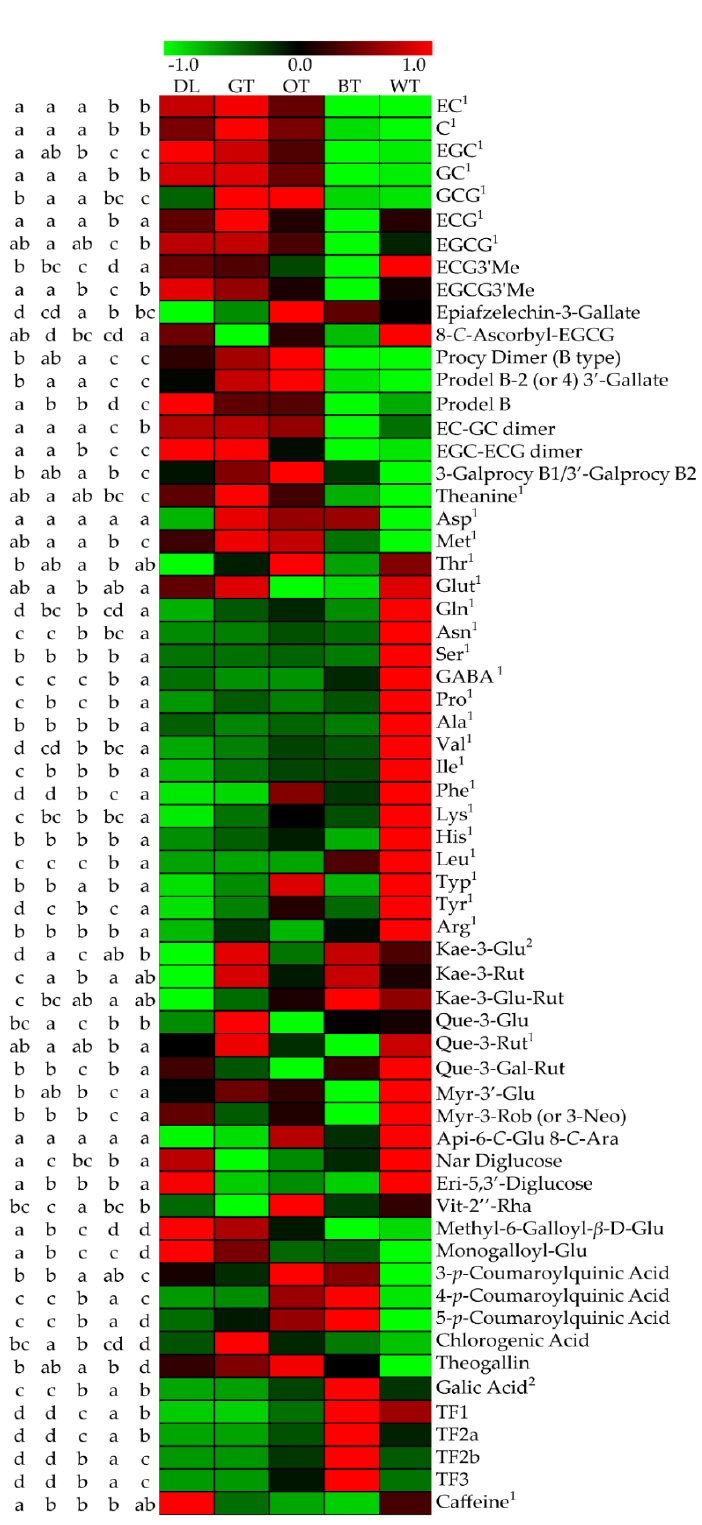
Figure 7. Comparisons of metabolite intensity in different tea types. Normalized values from three biological replicates were shown on a color scale proportional to the content of each metabolite and are expressed as log2. Lowercase letters on the left indicate significant differences ( p < 0.05) among different samples. Compound name on the right with superscript 1 means they were detected by UPLC-QqQ-MS and superscript 2 means they were confirmed by authentic standards detected by UPLC-QTOF-MS. Others were identified through MS/MS information from UPLC-QTOF-MS.